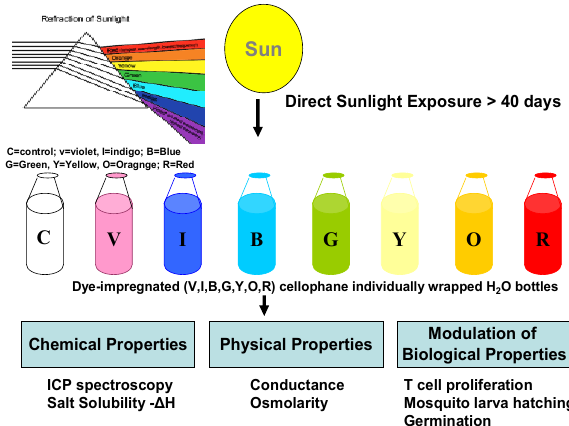
Figure1: Diagrammatic representation of the Chemical, Physical and Biological modifications in properties